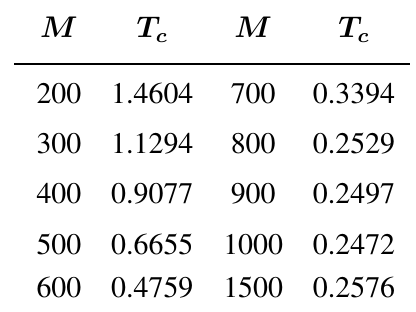
Table 1. Critical transition times T M